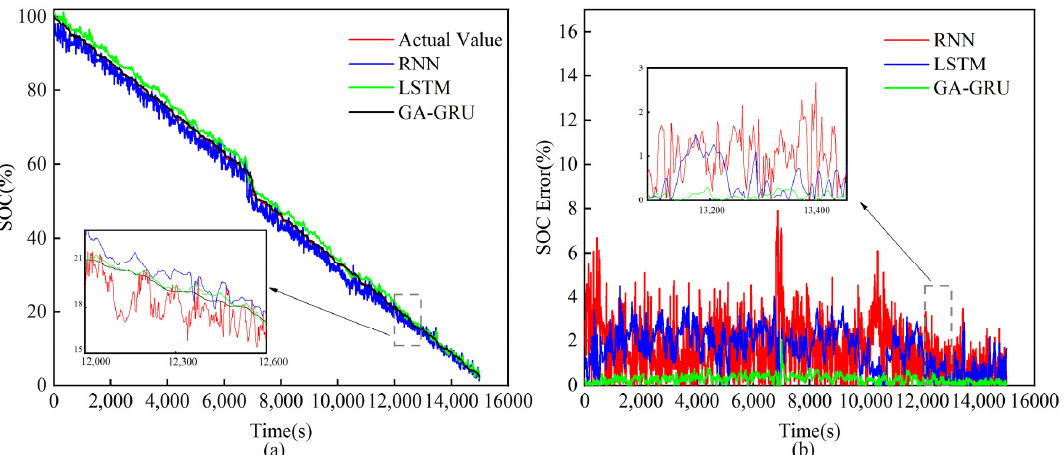
Figure 7. SOC estimation results and errors under FUDS at 10 °C. ( a ) Comparison of SOC estimation results under FUDS at 10 °C; ( b ) comparison of SOC estimation errors under FUDS at 10 °C.